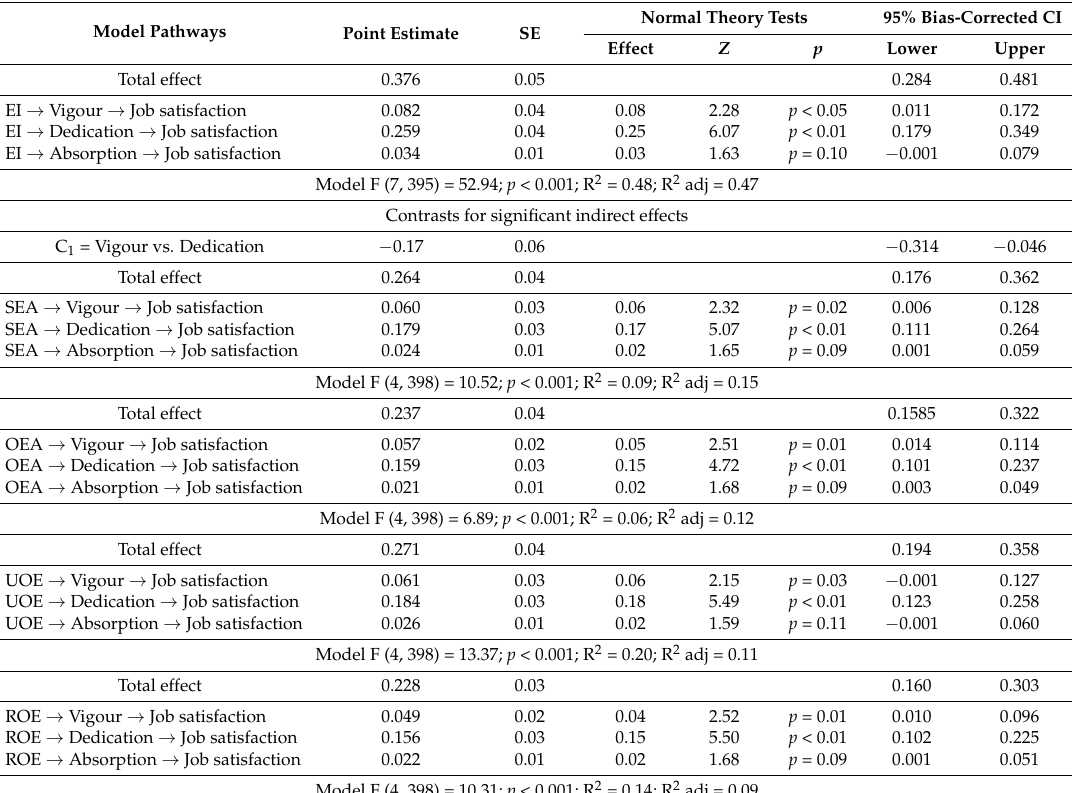
Table 3. Test of the mediating effect of work engagement